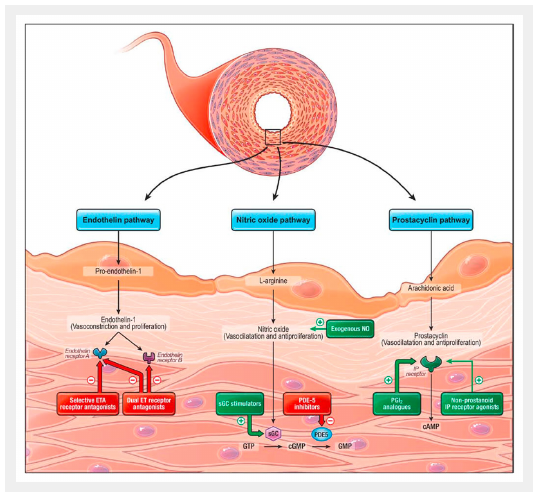
Established pathological pathways modulated by pharmacological substances currently used or in investigation for the treatment of pulmonary arterial hypertension. Antagonists or inhibitors are in red, activators or analogues are in green. (Reproduced with permission from: Humbert M, Lau EMT, Montani D, Jais X, Sitbon O, Simonneau G. Advances in therapeutic interventions for patients with pulmonary arterial hypertension. Circulation. 2014;130:2189–208.) cAMP = cyclic adenosine monophosphate; cGMP = cyclic guanosine monophosphate; GTP = guanosine triphosphate; ET = endothelin; ETA = endothelin type A receptor; IP = prostaglandin I2; NO = nitric oxide; PDE-5 = phosphodiesterase type 5; sGC = soluble guanylate